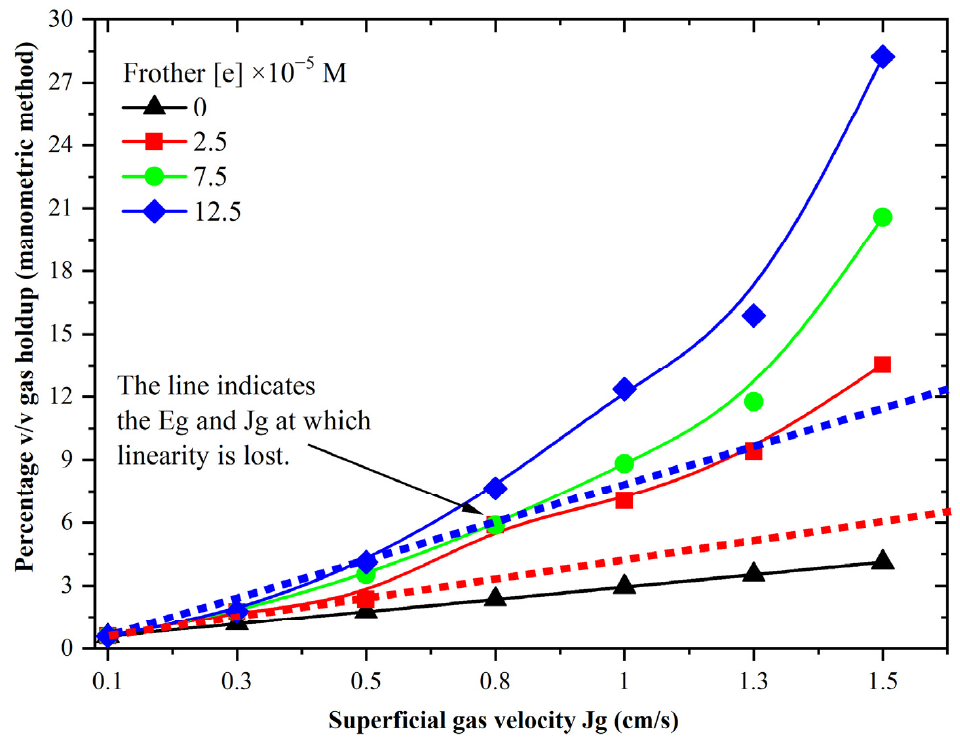
Figure 4. Percentage of v / v gas holdup as function of superficial gas velocity Jg (cm/s), Jl 0.19 cm/s, [e] 0, 2.5, 7.5, 12.5 × 10 − 5 M, rigid sparger.